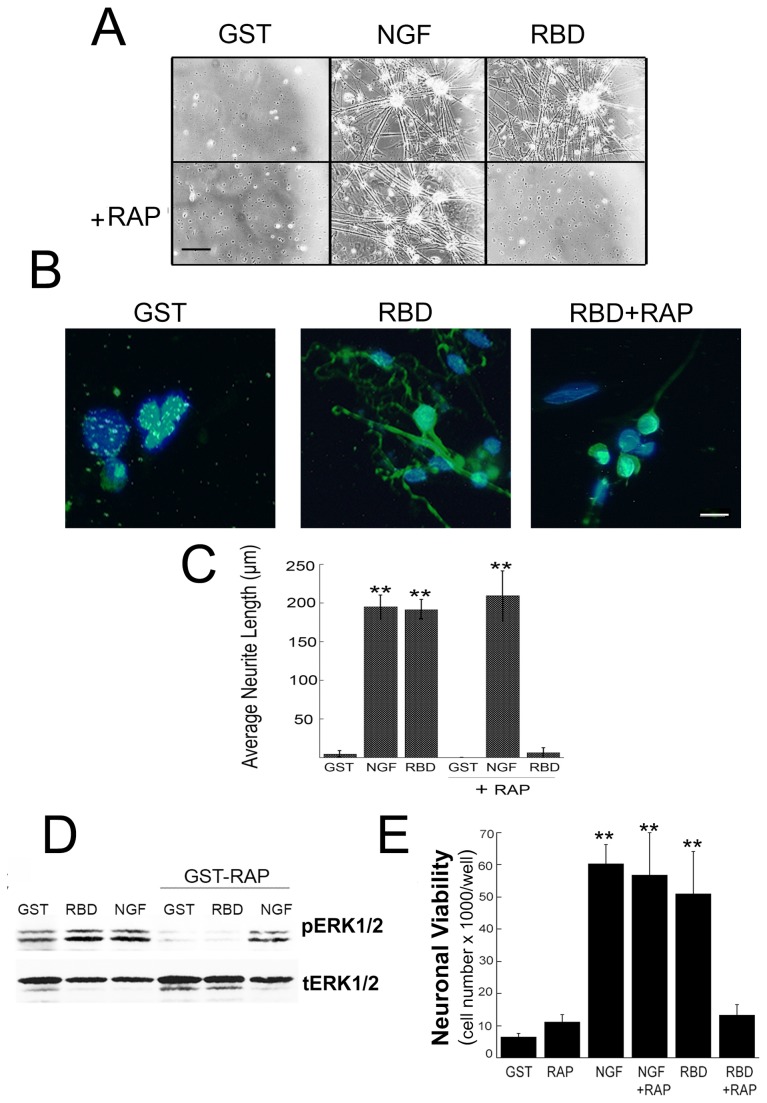
RBD promotes neurite sprouting in primary embryonic sensory neurons that is blocked by the LRP1 antagonist, GST-RAP.
A, Phase-contrast images of DRG neurons cultured on collagen using an inverted microscope. DRG neurons were pretreated with or without GST-RAP (200 nM) for 30 min prior to the addition of RBD or NGF (50 ng/ml). Images represent n=6 independent studies. Scale bar, 50 µm. B, Immunolabeling of primary embryonic neurons with β neuronal class II tubulin (Tuj1; green) and Dapi (blue). Scale bar, 15 µm. C, Quantification of neurite sprouting in DRG neurons. Data are expressed as mean ± SEM (n=4 independent studies). In each study, 3 replicate wells were used to measure a minimum of 30 axonal extensions. **p<0.01 compared with respective GST or RAP controls. D, Immunoblot analysis of ERK1/2 in GST-RAP-treated DRG neurons subsequently stimulated with RBD or NGF for 30 min. The blot represents 2 independent experiments. E, Quantification of neuronal viability after two weeks in primary culture. Data are expressed as mean ± SEM (n=3) (**p<0.01).